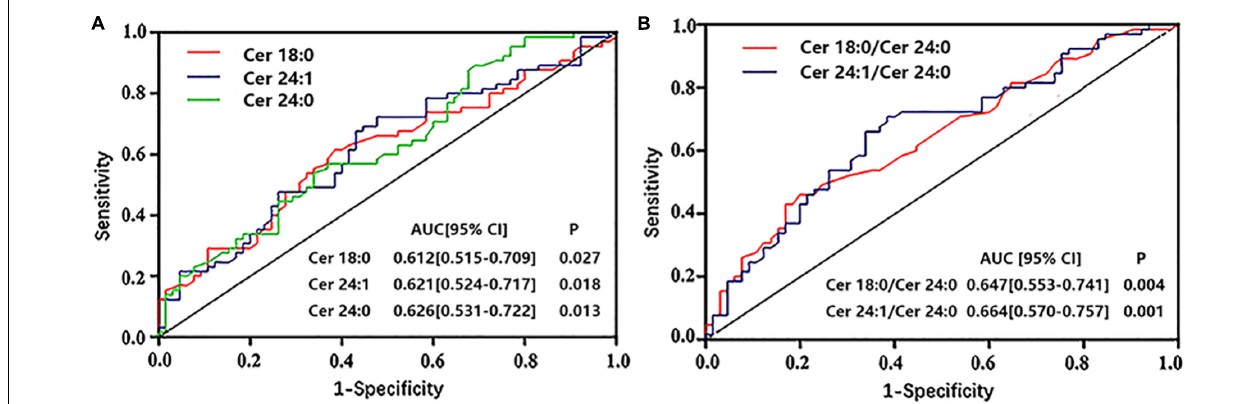
FIGURE 4 | (A,B) Receiver operator characteristic (ROC) curves of ceramides to predict comorbid acute coronary syndrome and type 2 diabetes mellitus. ROC analysis was performed to determine the sensitivity and specificity of the value. AUC, area under the curve; CI, confidence interval.